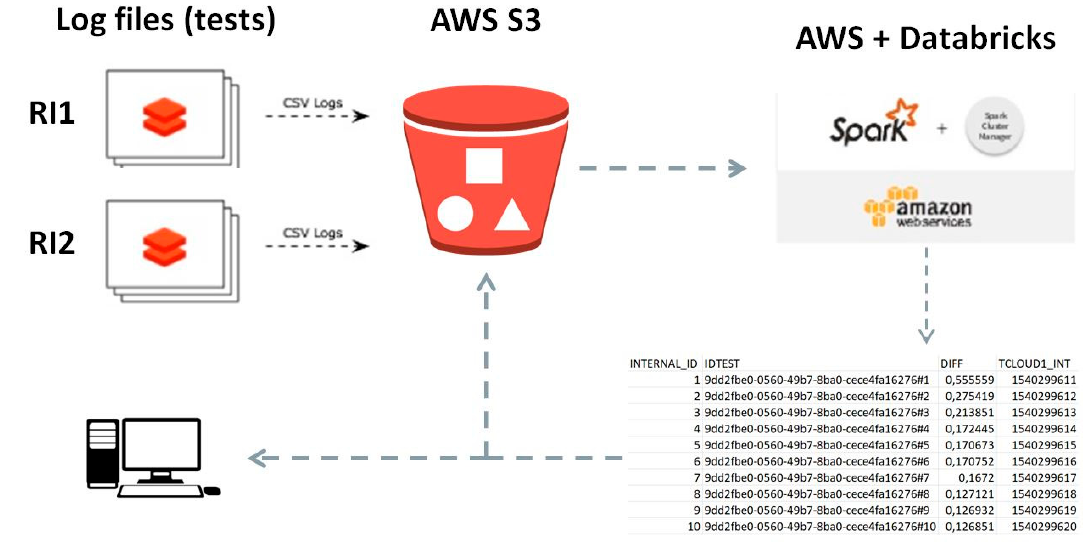
Figure 4. Logging data platform.